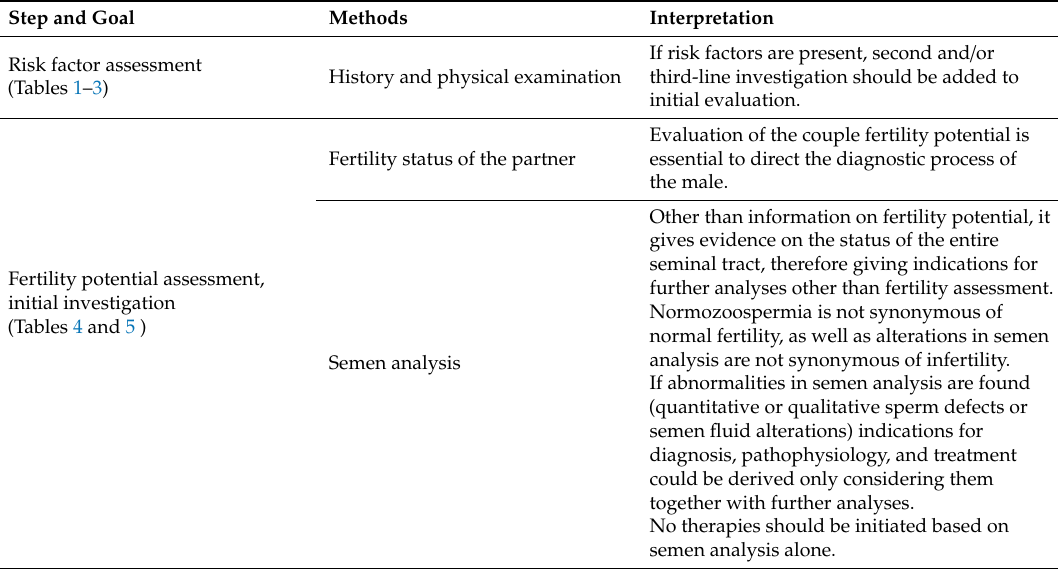
Table 7. Summary of investigation of the male partner of an infertile couple or men who question their fertility